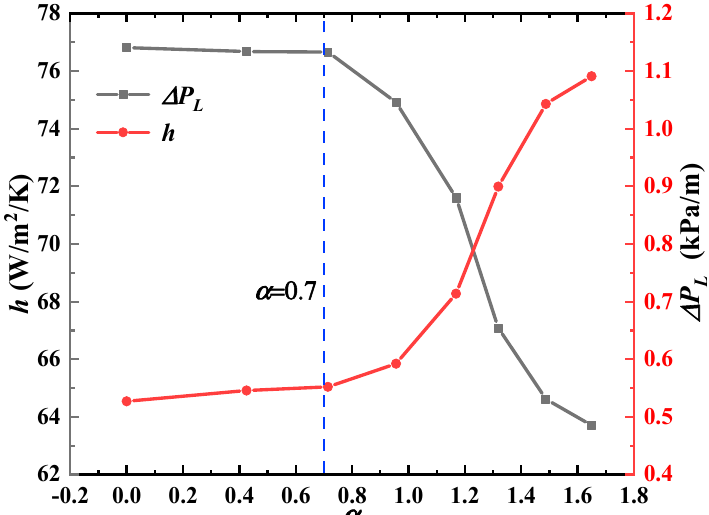
Figure 9. Heat transfer coefficient and pressure drop variations with maldistribution coefficients for DF-PCHE channels without SPB.